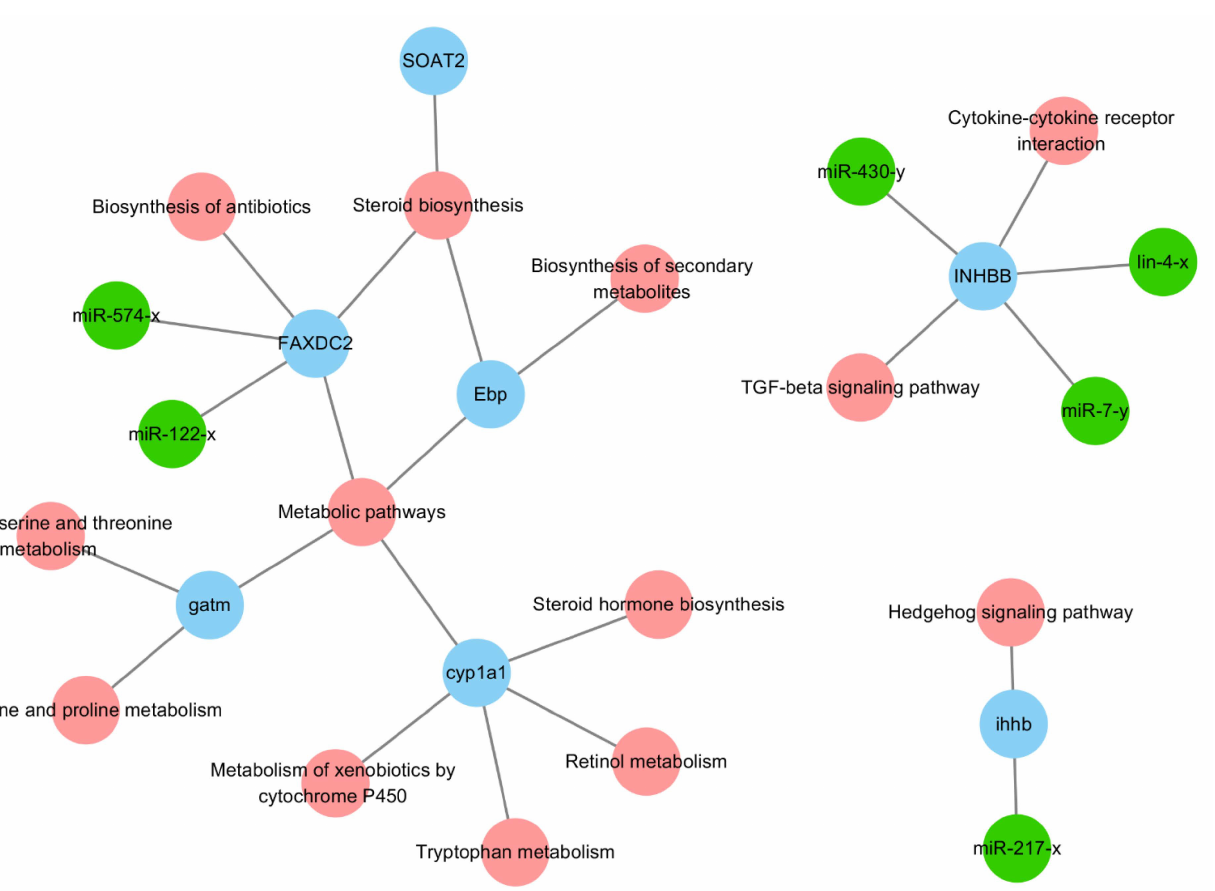
Figure 4. The networks of the selected miRNAs and mRNAs. lin-4-x and miR-7-y were found to have negative correlations with faxdc2 , inhbb , ihhb , soat2 , and gatm, and miR-574-x was found to have a significant negative correlation with faxdc2 (Supplementary Table